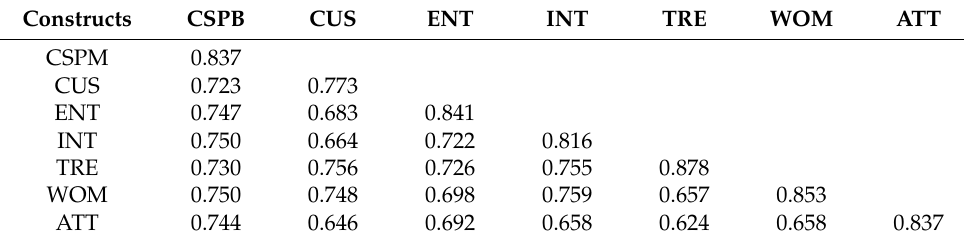
Table 2. Discriminant